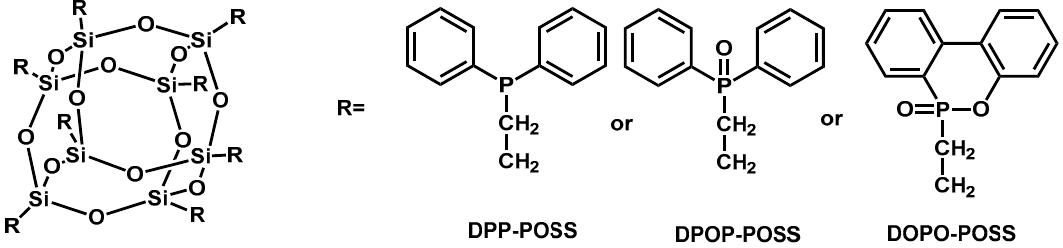
Figure 17. Structure of DPP-POSS, DPOP-POSS, and DOPO-POSS. Readapted with permission from Ref. [160], Copyright 2007, Elsevier Ltd.